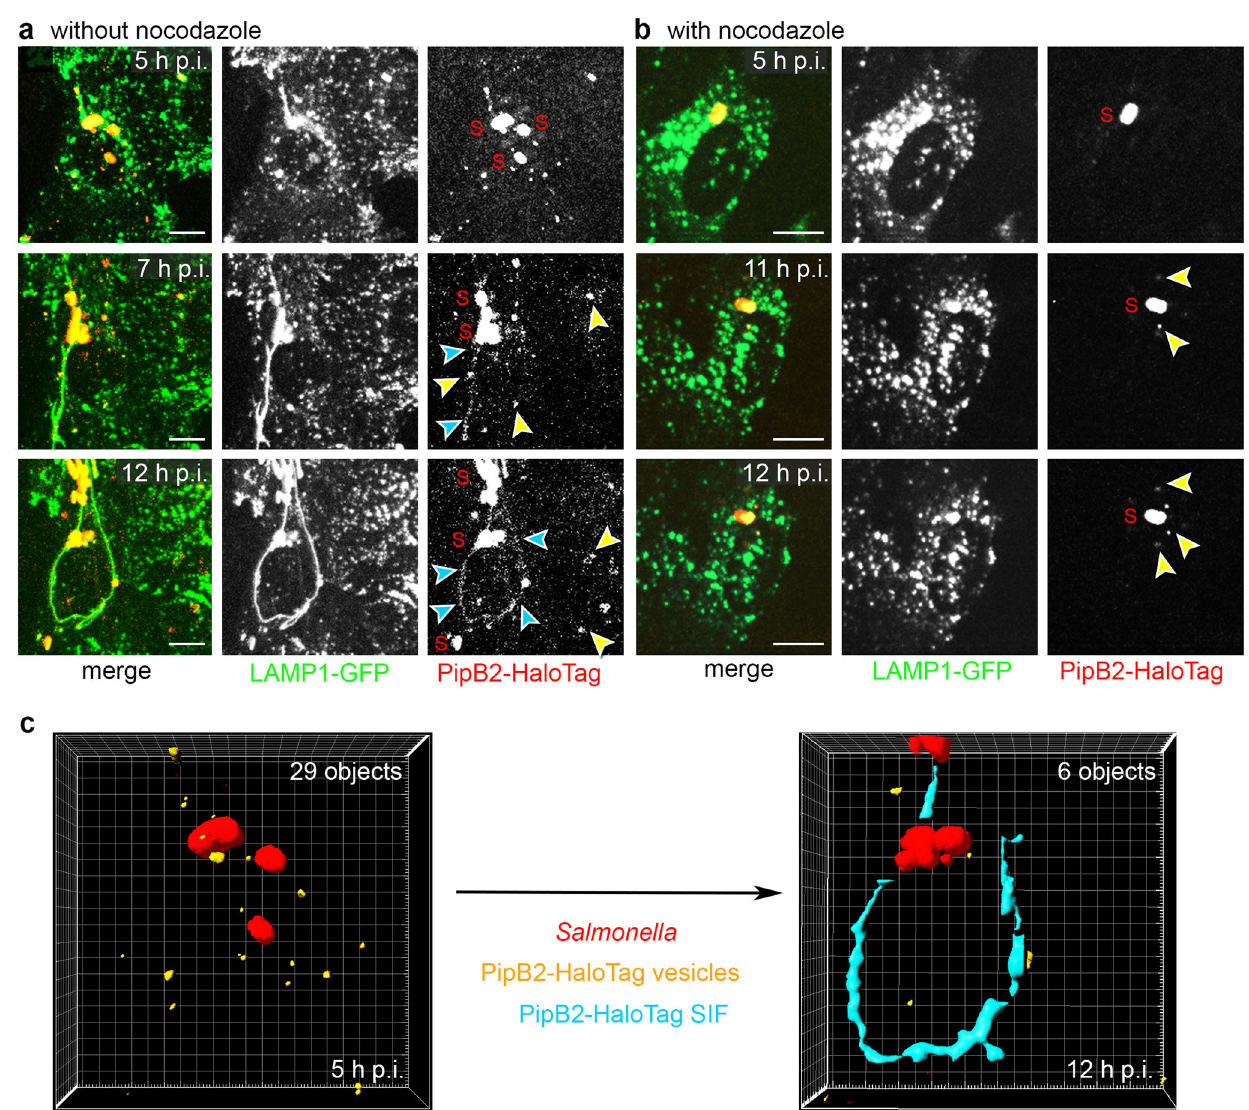
Fig. 8 | Conversionofvesicular to tubulardistributionoftranslocatedeffector proteins. HeLa LAMP1-GFP cells were infected with STM Δ pipB2 strain expressing pipB2 ::HaloTag::HA. Cells were either not treated ( a ), or treated with nocodazole (5 µ gml − 1 )2hp.i. b TheinhibitorwasremovedafterHaloTagstainingandcellswere washed twice. LCI was performed using SDM directly after cells were stained with 1 µ M HTL-TMR for 30min. The cellswereimaged overa periodof 8h every30min (Supplementary Movie 15, Supplementary Movie 16). Representative STM are